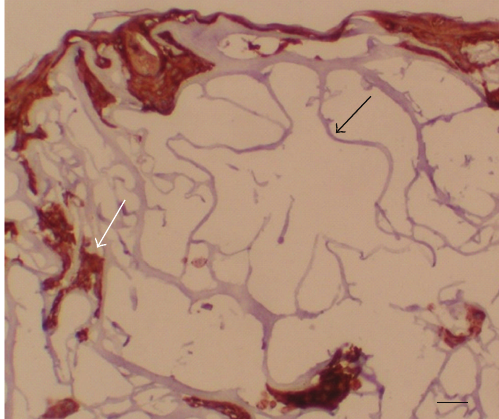
Figure 7: Keratinocytes cultured on Biopad (equine collagen). Note the fragile collagen fibers (black arrow) and the chaotic distribution of the irregular groups of keratinocytes. Immunohistological detec- tion of involucrin shows terminally di ff erentiated keratinocytes in the inner structure of Biopad (white arrow). Bar—30 μ